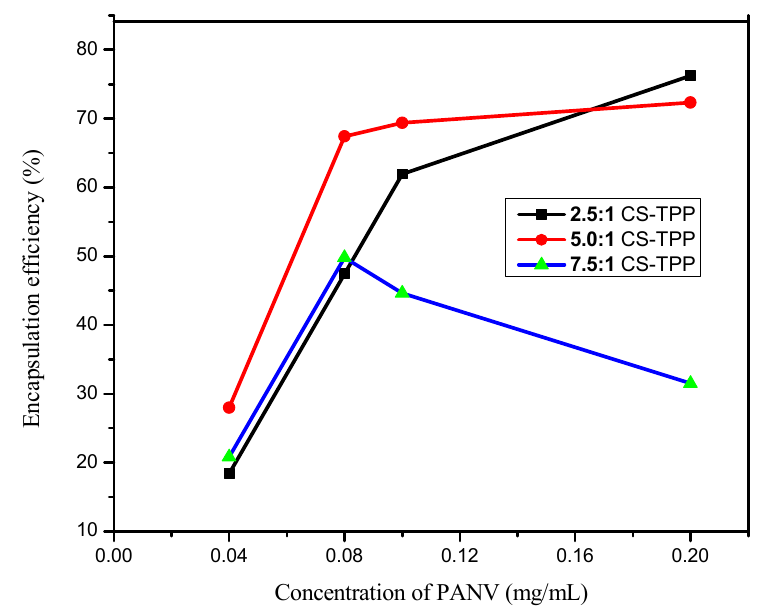
Figure 9. The effect of the PANV concentration on encapsulation efficiency.